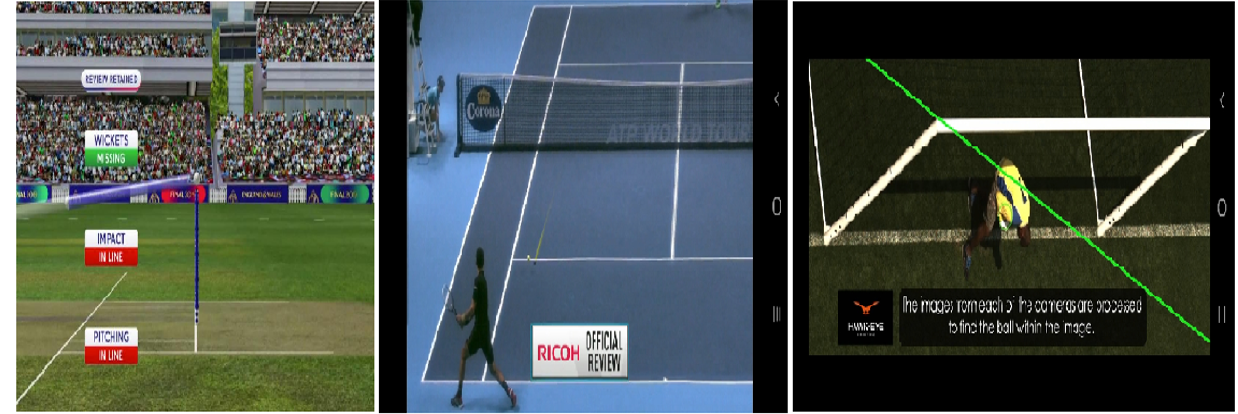
Figure 16. Hawkeye technology in cricket, tennis and soccer [290–292].